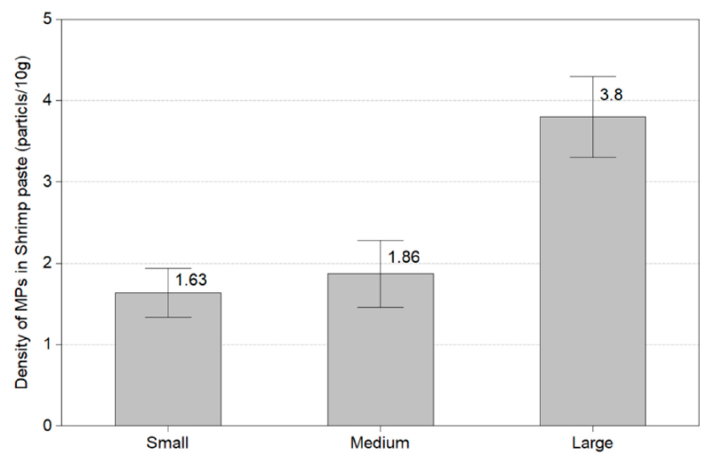
Figure 6. Amount of microplastics by size of shrimp. Figure 7 shows the size of microplastics by the size of the shrimp. The microplastic ratio by the size of small shrimp was found to be 53% under 50 µ m, 39% between 50 µ m and 100 µ m, and 8% between 100 µ m and 150 µ m. The microplastic size ratio of medium-sized shrimp was 46% under 50 µ m, 39% between 50 µ m and 100 µ m, and 14% between 100 µ m and 150 µ m. The microplastic size ratio of large shrimp was found to be 46% under 50 µ m, 31% between 50 µ m and 100 µ m, and 3% between 100 µ m and 150 µ m. In most shrimp, the proportion of microplastics less than 100 µ m was high from 77% to 92%.